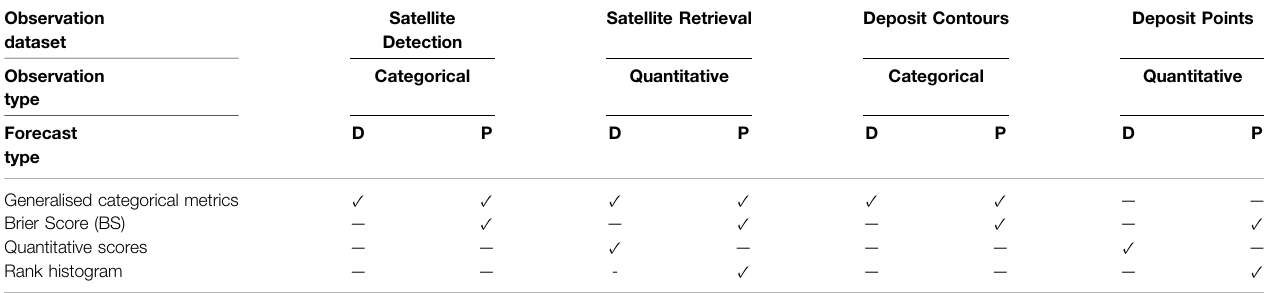
TABLE 2| Four types of observation datasets that canbe used for model validationby task PosVal . The satellite detection and the satellite retrieval observation types stand, respectively, for detection ( i.e. “ yes/no ” categorical observation) and quantitative column mass retrievals. The deposit contours observation type refers to isopach/ isoplethdepositcontours( e.g. fromshape fi lesorgriddedmaps).Finally,thedepositpointsstandsfordepositthickness/loadobservationsatscatteredpoints.Foreachtype of forecast, deterministic (D) or probabilistic (P), the Table indicates which validation metrics apply to each combination of observation-forecast types. The different generalised categorical and quantitative scores are de fi ned in Section 3